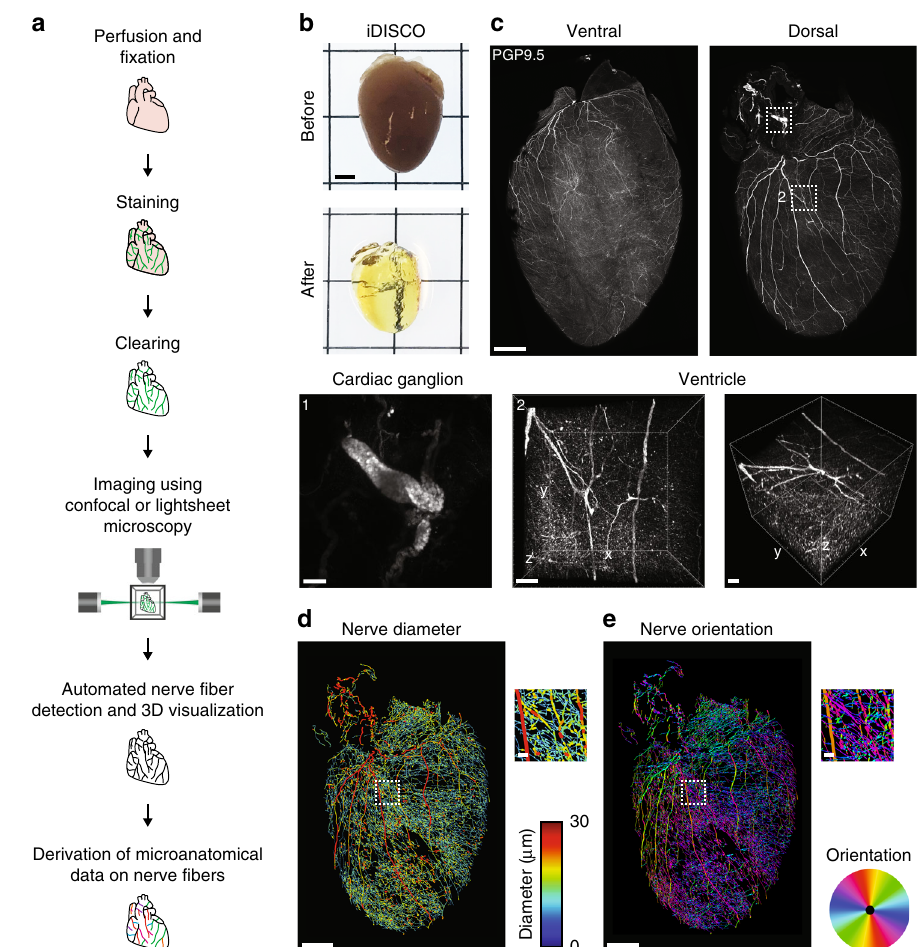
Fig. 1 Tissue clearing and computational pipeline to assess cardiac innervation. a Schematic of the clearing-imaging-analysis pipeline for assessing cardiac innervation. b A whole heart (top) was rendered transparent (bottom) using the iDISCO protocol. c 3D confocal projections of the ventral (1500 µ m z- stack) and dorsal side of a cleared heart (1200 µ m z-stack) with PGP9.5 staining (gray). Inset 1 shows a maximum intensity projection (MIP) confocal image of a cardiac ganglion. Inset 2 shows 785 µ m-thick 3D projections of the entire left ventricular wall. d , e A semiautomated computational pipeline was used to detect nerve fi bers in the dorsal heart image from ( c ) and derive their diameter ( d ) and orientation ( e ). Insets show higher magni fi cation images. Scale bars are 2 mm ( b ), 1 mm ( c (top), d (left), e (left)), and 100 µ m ( c (bottom), d (right), e